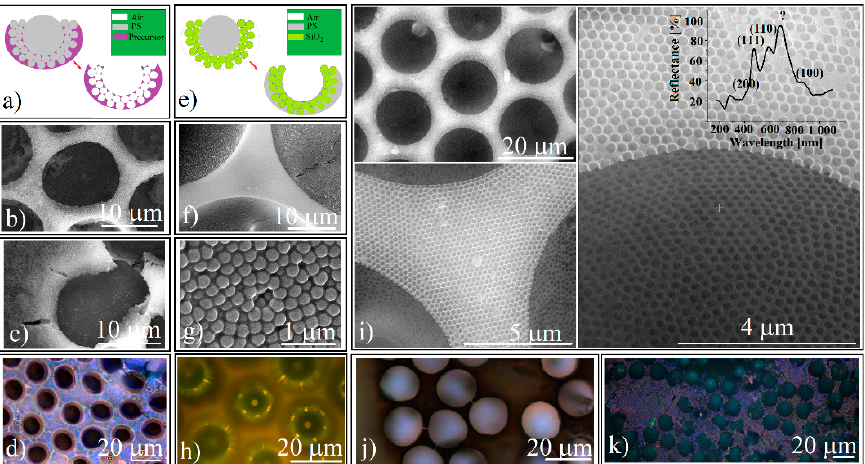
Figure 5. ( a ) Schematical of liquid precursor infiltration and calcination steps for inverse opal-ordered concavities synthesis; ( b ) SEM image of sodium silicate (Na 2 SiO 3 ) inverse opal-ordered concavities synthesized by liquid precursor infiltration; ( c ) SEM image of TiO 2 inverse opal-ordered concavities synthesized by liquid precursor infiltration; ( d ) reflection optical microscopy image of sodium silicate inverse opal-ordered concavities synthesized by liquid precursor infiltration; ( e ) Schematical of polystyrene melt infiltration from inside for PS inverse opal-ordered concavities synthesis; ( f ) SEM image of polystyrene-infiltrated ordered concavities; ( g ) SEM close-up view of polystyrene-infiltrated concavities; ( h ) reflection optical microscopy image of polystyrene infiltrated concavities; ( i ) SEM images of polystyrene inverse opal concavities array at three different magnifications and their reflectance spectrum (inset); ( j ) transmission optical microscopy image of polystyrene inverse opal concavities array; ( k ) reflection optical microscopy image of polystyrene inverse opal concavities.